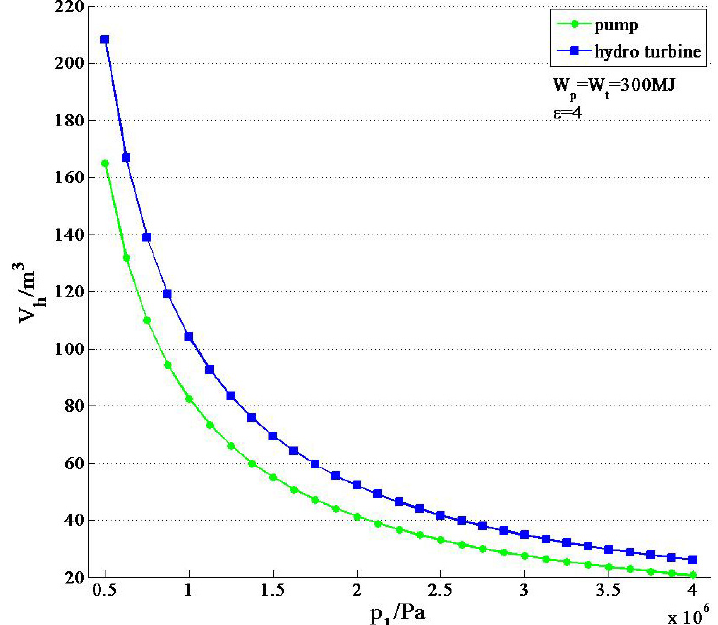
Figure 8. Vessel volume various with pre-set pressure.